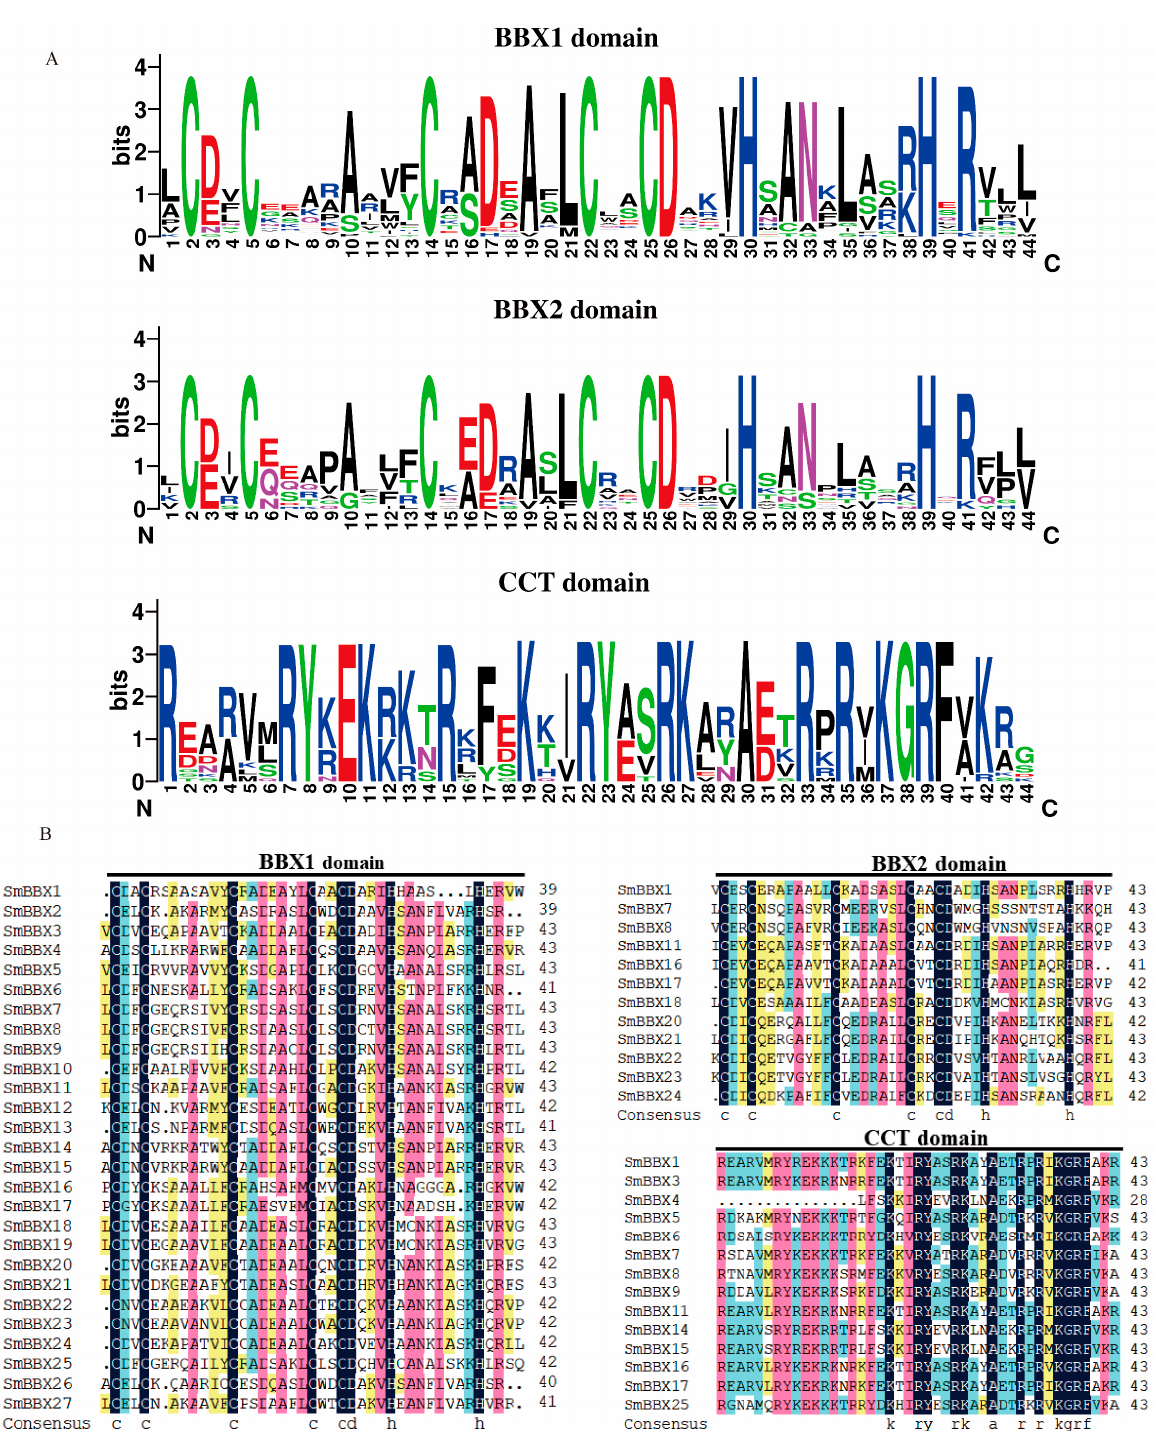
Figure 1. Composition of SmmBBXs protein domains. ( A ) Amino acid sequence alignment of B-box1, B-box2, and CCT domains. The y-axis indicated the conservation rate of each amino acid, the x-axis indicated the conserved sequences of the domain. ( B ) Multiple sequence alignments of the SmBBXs domains. Multiple sequence alignments of B-box1, B-box2, and CCT domains are shown. Identical conserved amino acids are highlighted black.